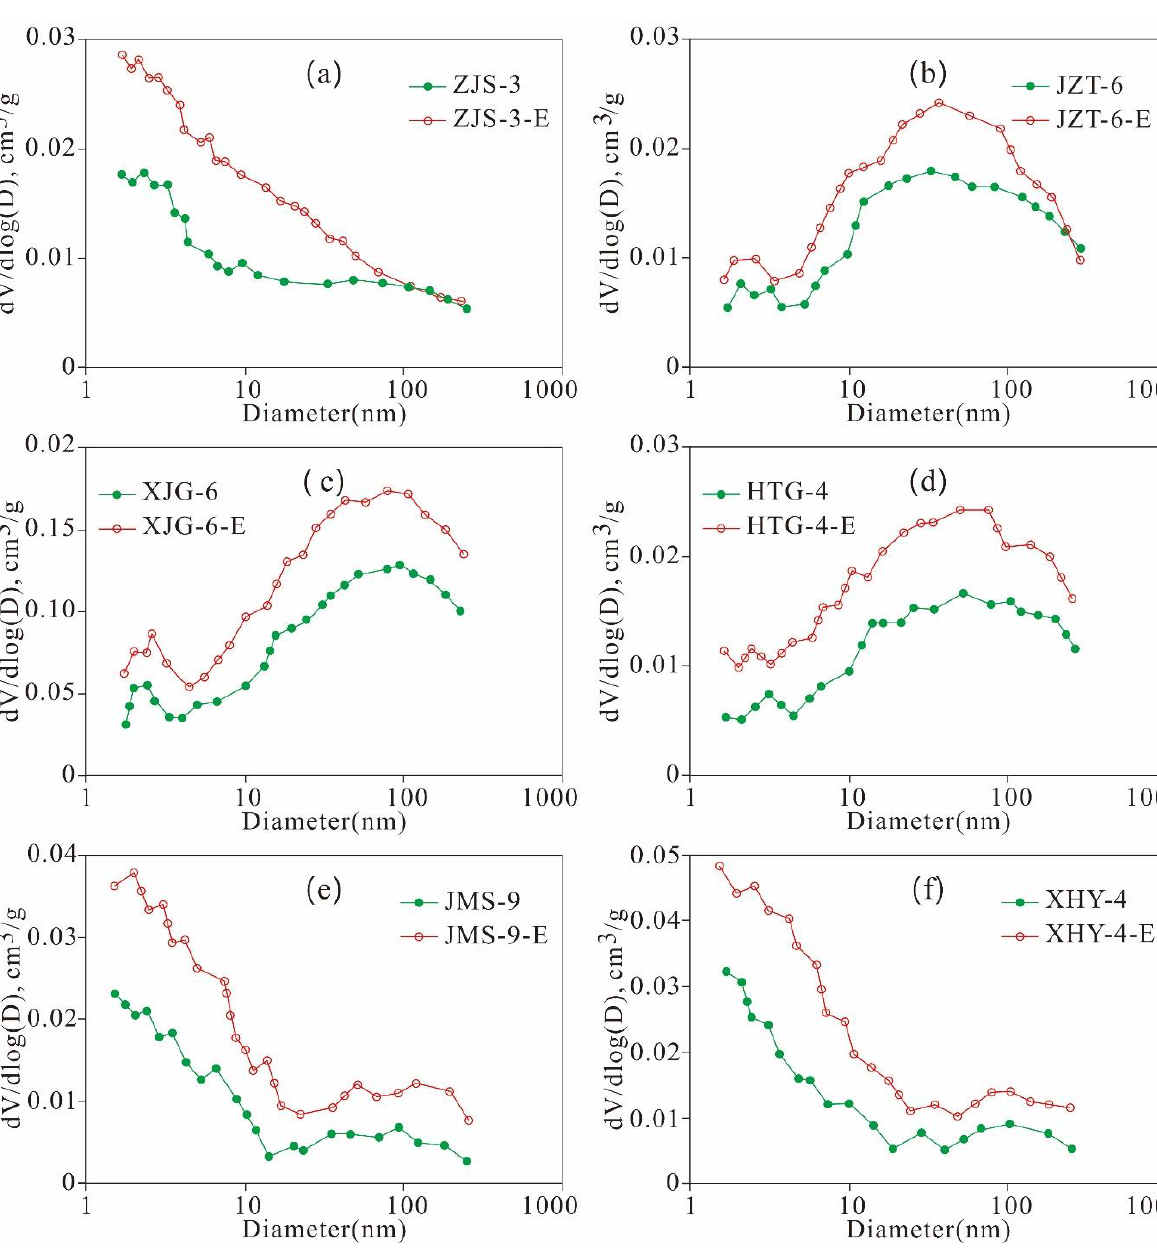
Figure 23. Meso- and macro-PV of the original shale and its corresponding extracted sample varies with the pore size (( a ), ZJS-3; ( b ), JZT-6; ( c ), XJG-6; ( d ), HTG-4; ( e ), JMS-9; ( f ), XHY-4).